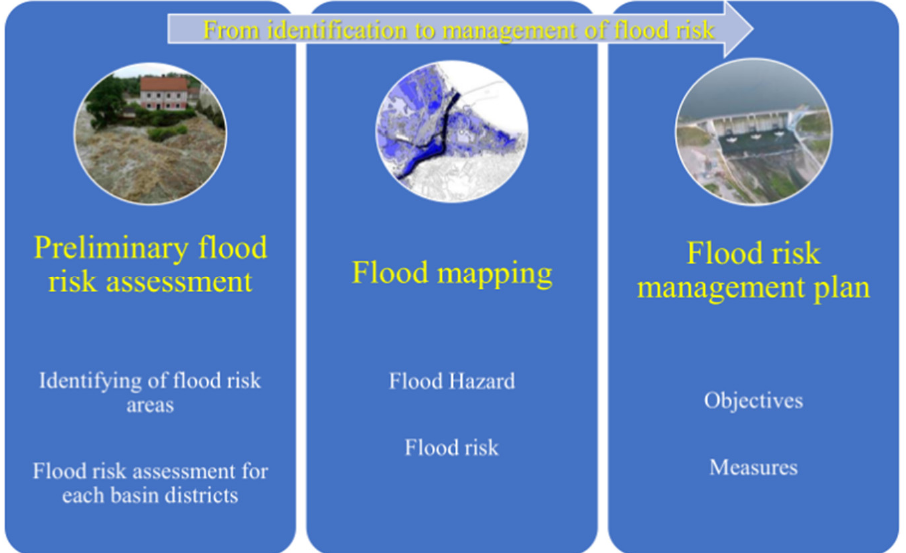
Figure 4. Three ‐ stage process established by the European Flood Directive. Figure 4. Three-stage process established by the European Flood